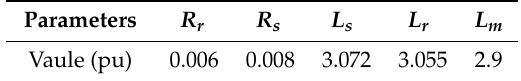
Table A1. Parameters of DFIG.